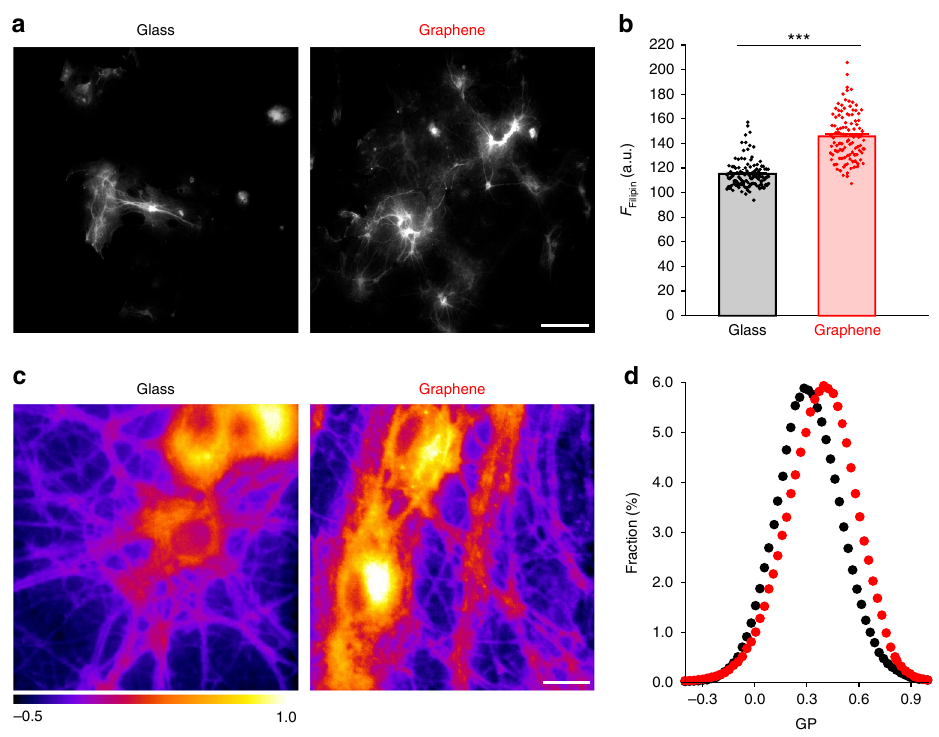
Fig. 3 Graphene increases cell membrane cholesterol. a Sample images of Filipin staining. Scale bar, 100 μ m. b Filipin fl uorescence intensity in neuronal neurites ( n glass = 118 and n graphene = 112 neurites, N = 3 batches, *** p < 0.001, Wilcoxin rank-sum test, Cohen ’ s d = 1.89). c Sample generalized polarization (GP) images. Scale bar, 20 μ m. d Distributions of GP values over individual image pixels ( n = 7 FOVs, N = 3 batches; p < 0.05, Kolmogorov – Smirnov test of the distributions of GP values, see 'Statistical analysis' section in Methods). Error bars are